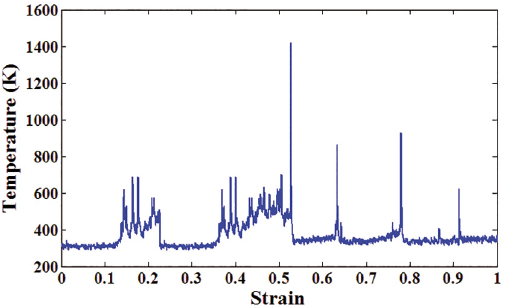
Figure 5: Temperature of a 30×50 Å 2 armchair graphenylene versus strain.